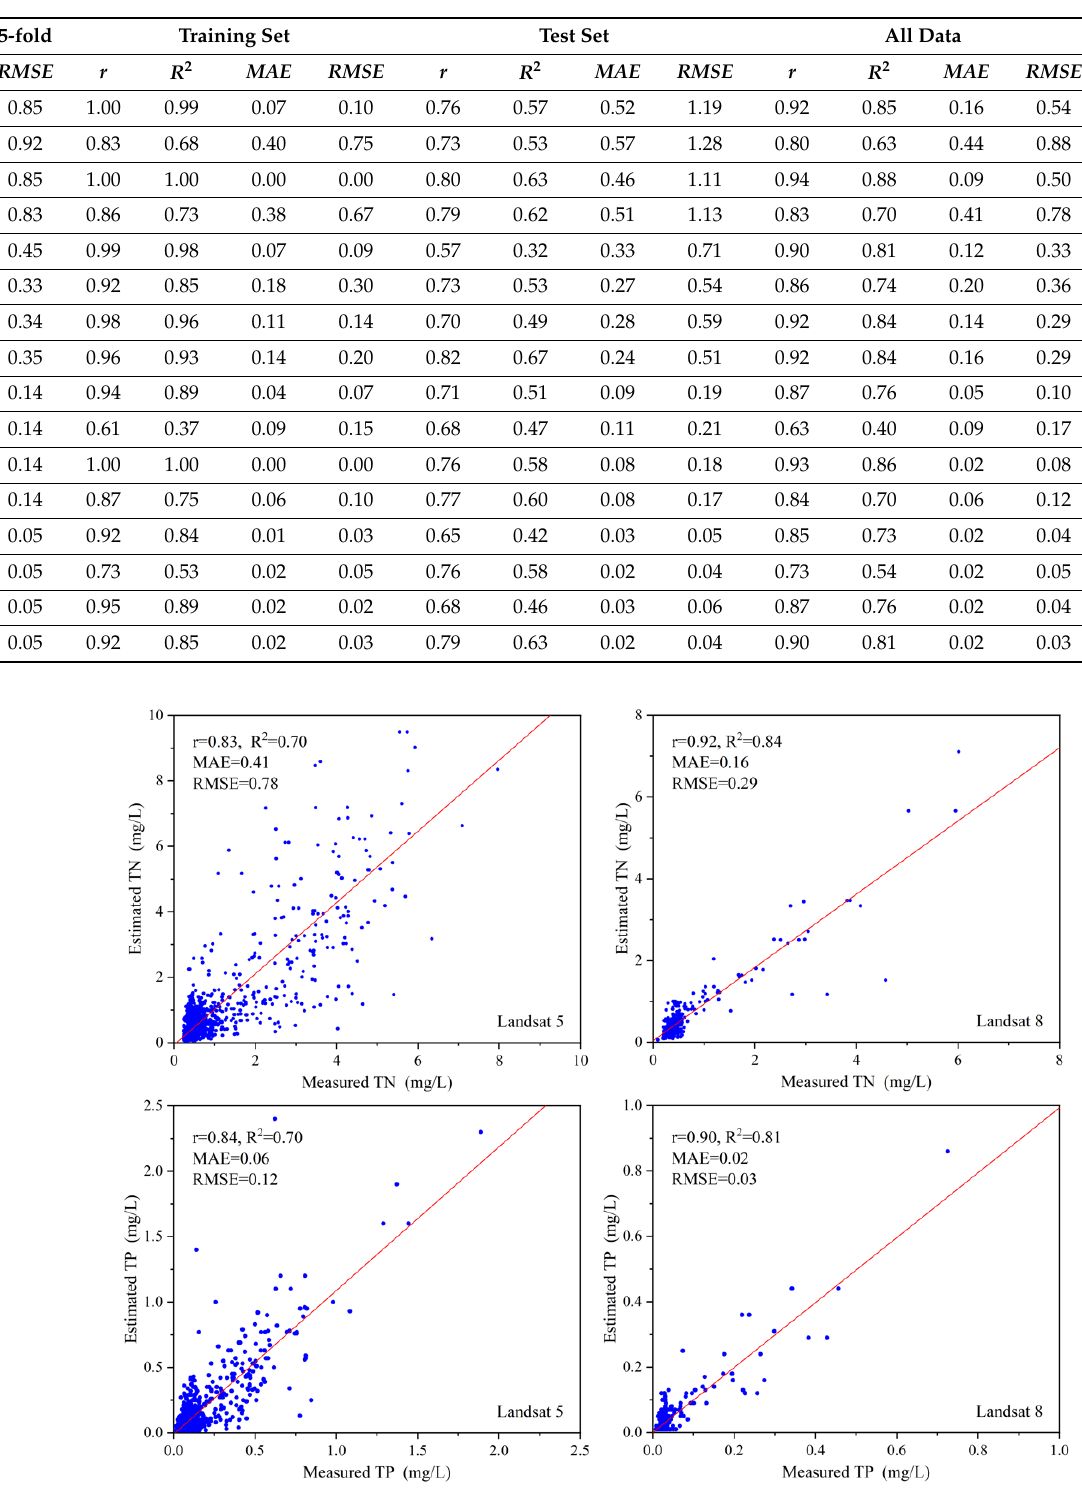
Figure 2. Performance evaluation of the Back-propagation Neural Network (BPNN) using all data.